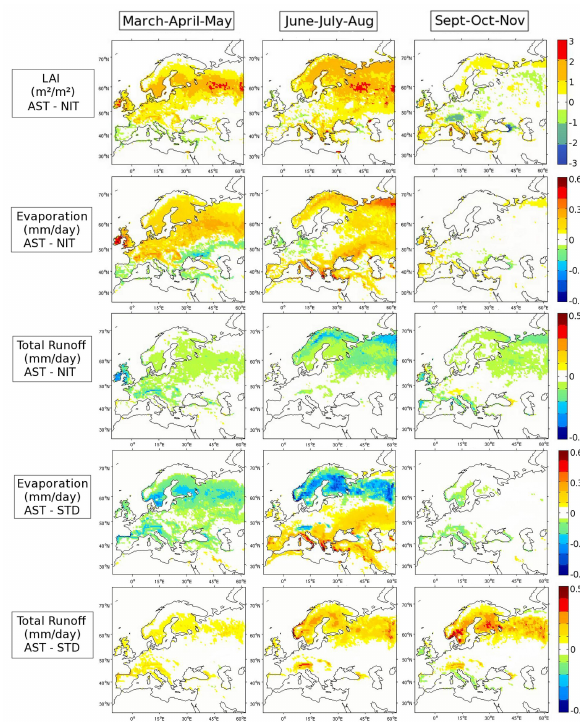
Fig. 12. Seasonal differences in LAI, evapotranspiration and total runoff (surface runoff+deep drainage) of the various LSM-TRIP simulations over the CNF area over the 1991–2008 period. From left to right: spring, summer and autumn. From top to bottom: LAI (ECOCLIMAP-II climatology used in AST and STD minus NIT), evapotranspiration and total runoff (first AST minus NIT, second AST minus